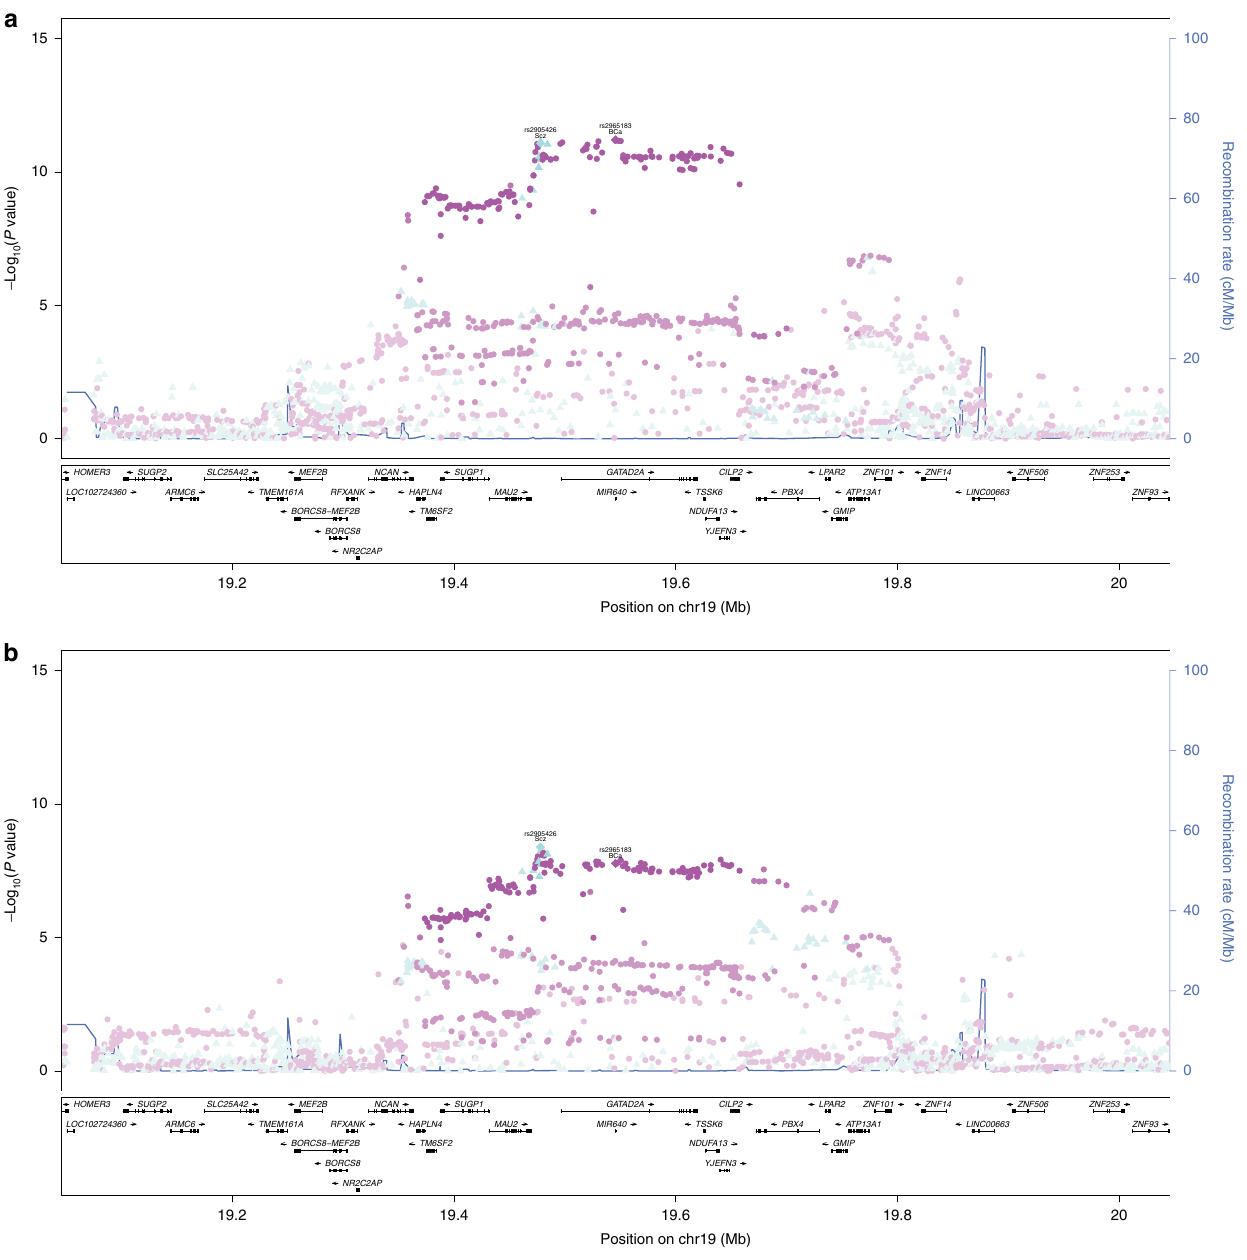
Fig. 3 Regional association plot of GWAS summary statistics from breast cancer and schizophrenia for the locus 19p13. a Associations with breast cancer. b Associations with schizophrenia. SNPs are colored corresponding to which of the lead SNPs it is in highest LD with, and the gradient of color denotes the extent of LD (i.e., lighter color means lower LD). This locus is anchored by lead SNPs rs2965183 (magenta) and rs2905426 (turquoise) for breast cancer and schizophrenia, respectively. GWAS genome-wide association study, LD linkage disequilibrium, SNP single-nucleotide